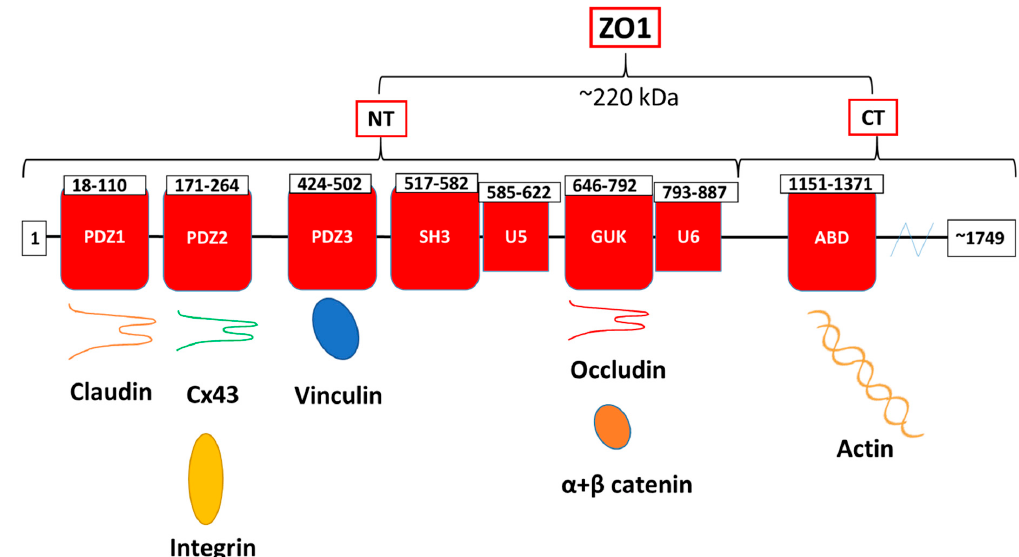
Figure 2. TJ adaptor ZO1 structure and its interacting partners in barrier function regulation. ZO1 consists of three PSD95, DlgA, ZO1 homology (PDZ) domains (PDZ 1, PDZ 2, and PDZ 3), a SRC homology 3 (SH3) domain, a yeast Guanylate Kinase homology (GUK) domain, and Unique-5 and -6 motifs (U5, U6) within its NT half, and an actin-binding domain (ABD) within its CT portion.